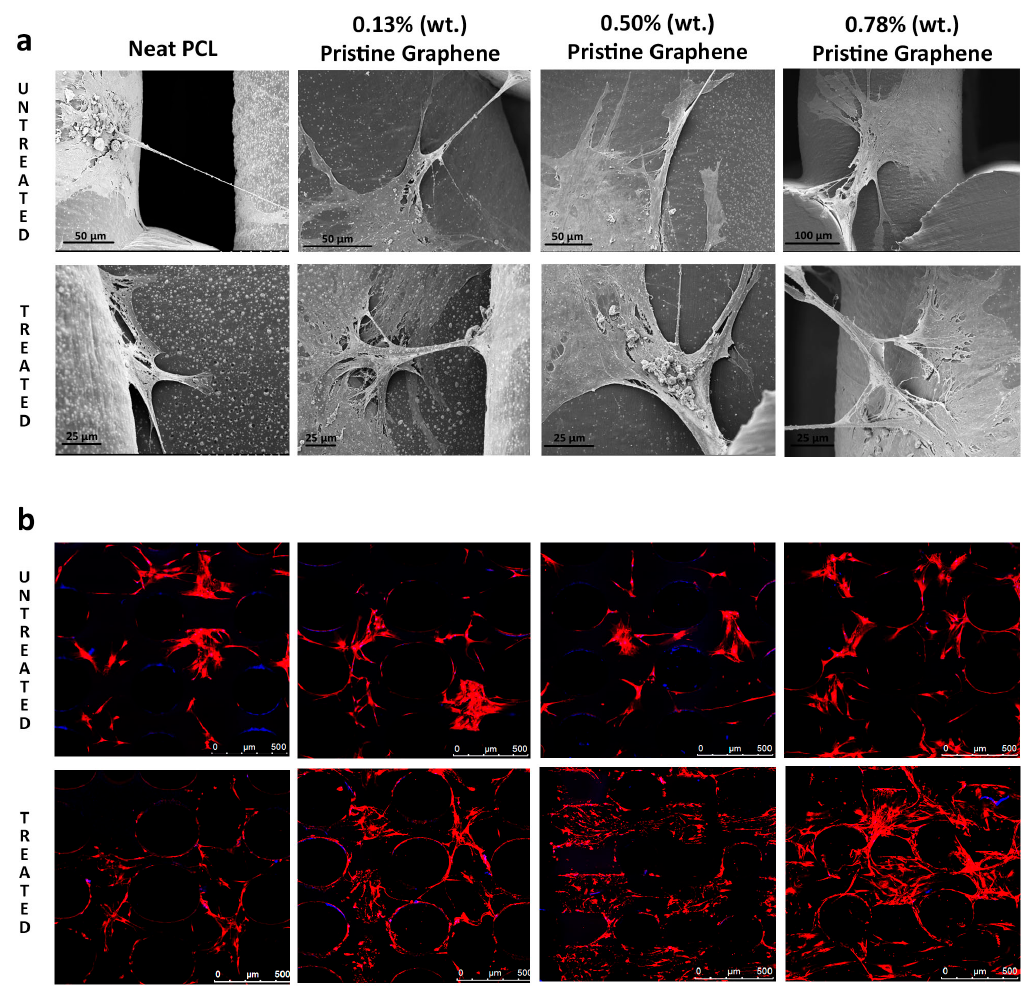
Figure 5. Cells attached on the scaffold. ( a ) SEM images after 21 days culture; ( b ) confocal images after 28 days culture.